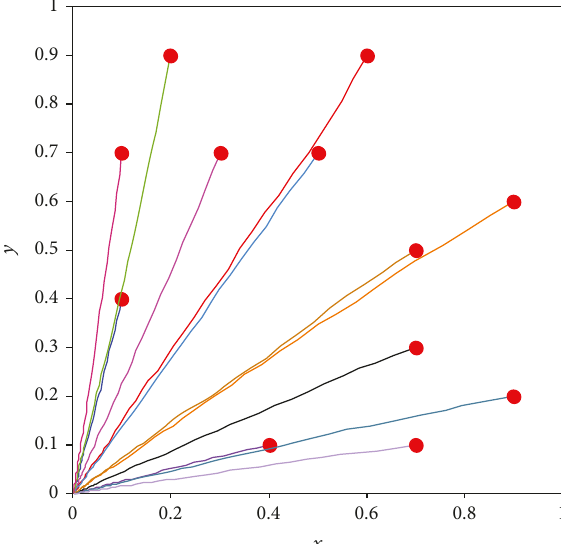
Figure 10: x and y during the learning process of EAQR in Case 1 ( ε = 0 9